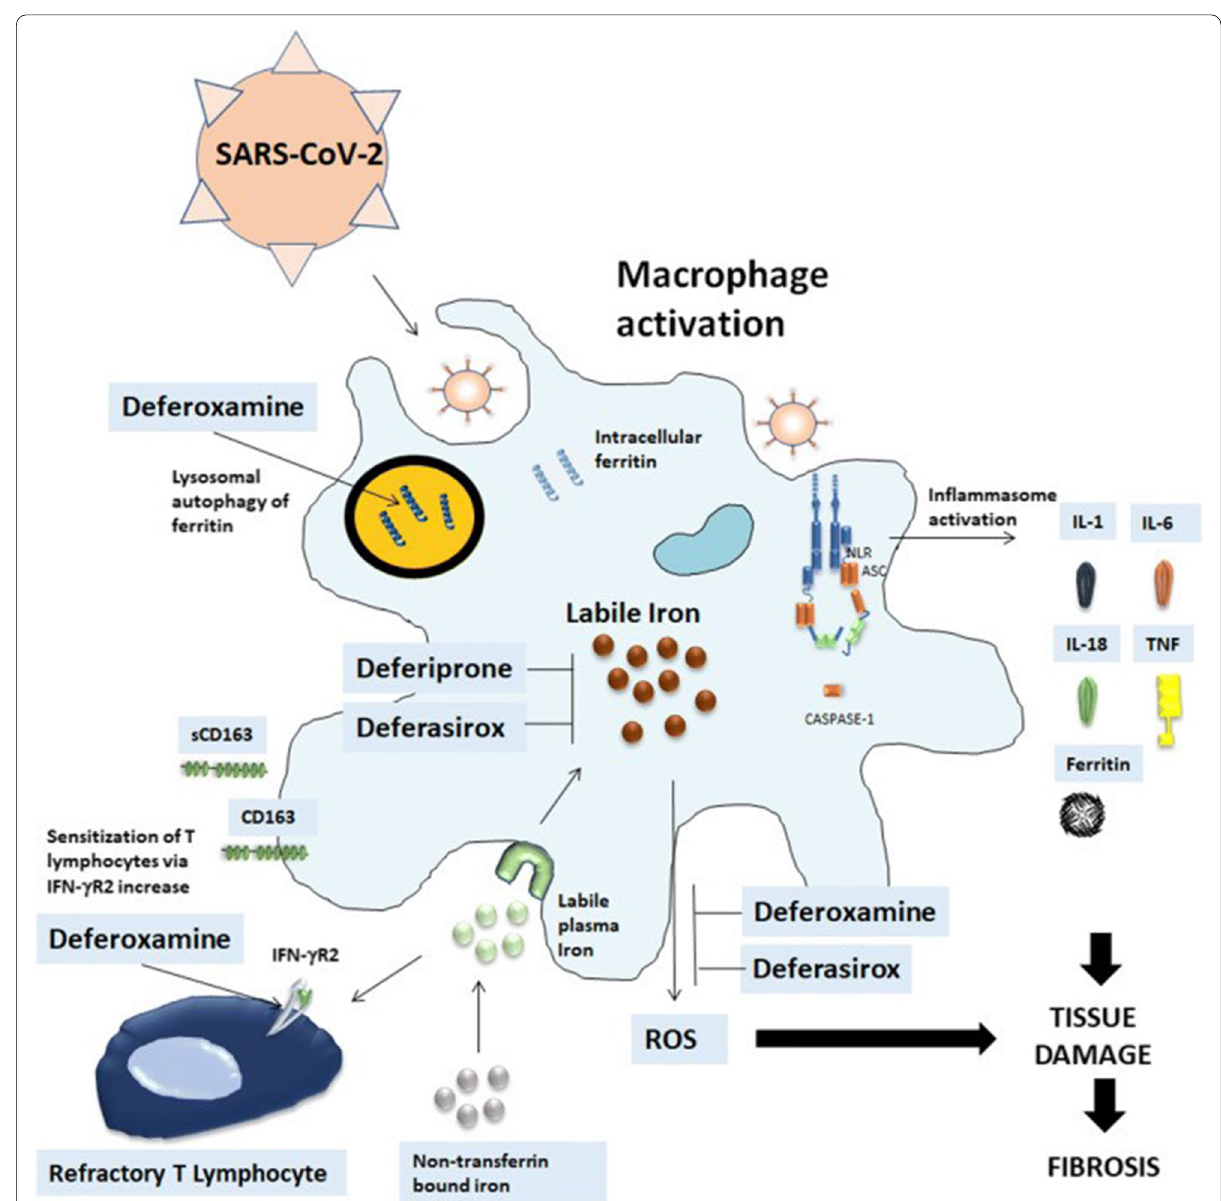
Fig. 2 Deferoxamine action (https:// europ epmc. org/ artic le/ med/ 32681